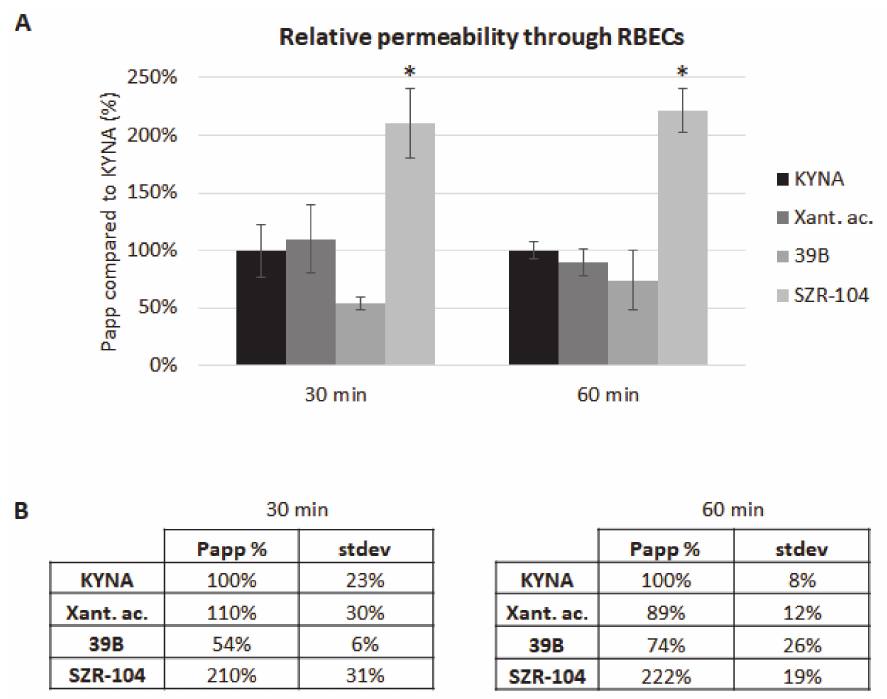
Figure 6. Penetration of SZR-104 through the BBB . (A) Permeability of SZR-104 after 30 and 60 min compared to KYNA, xanthurenic acid and its analogue, 39B. N = 3, average ± SD. * p < 0.01 (SZR-104: significant difference compared to all other groups, in both time-points). (B) Permeability coefficients of SZR-104, xanthurenic acid and 39B after 30 and 60 min compared to